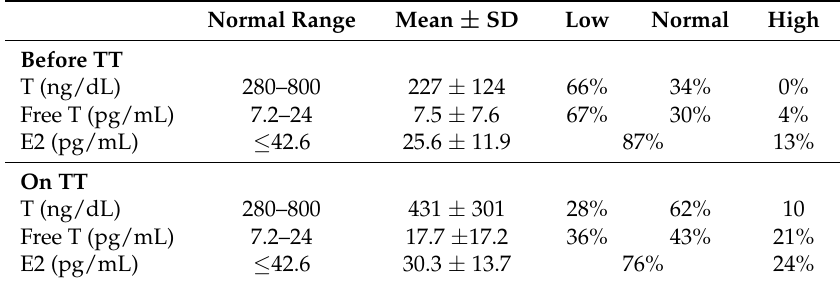
Table 1. Serum testosterone (T), free T, and estradiol (E2) in 29 men before and on testosterone gel treatment (median 50 mg/day). TT: testosterone